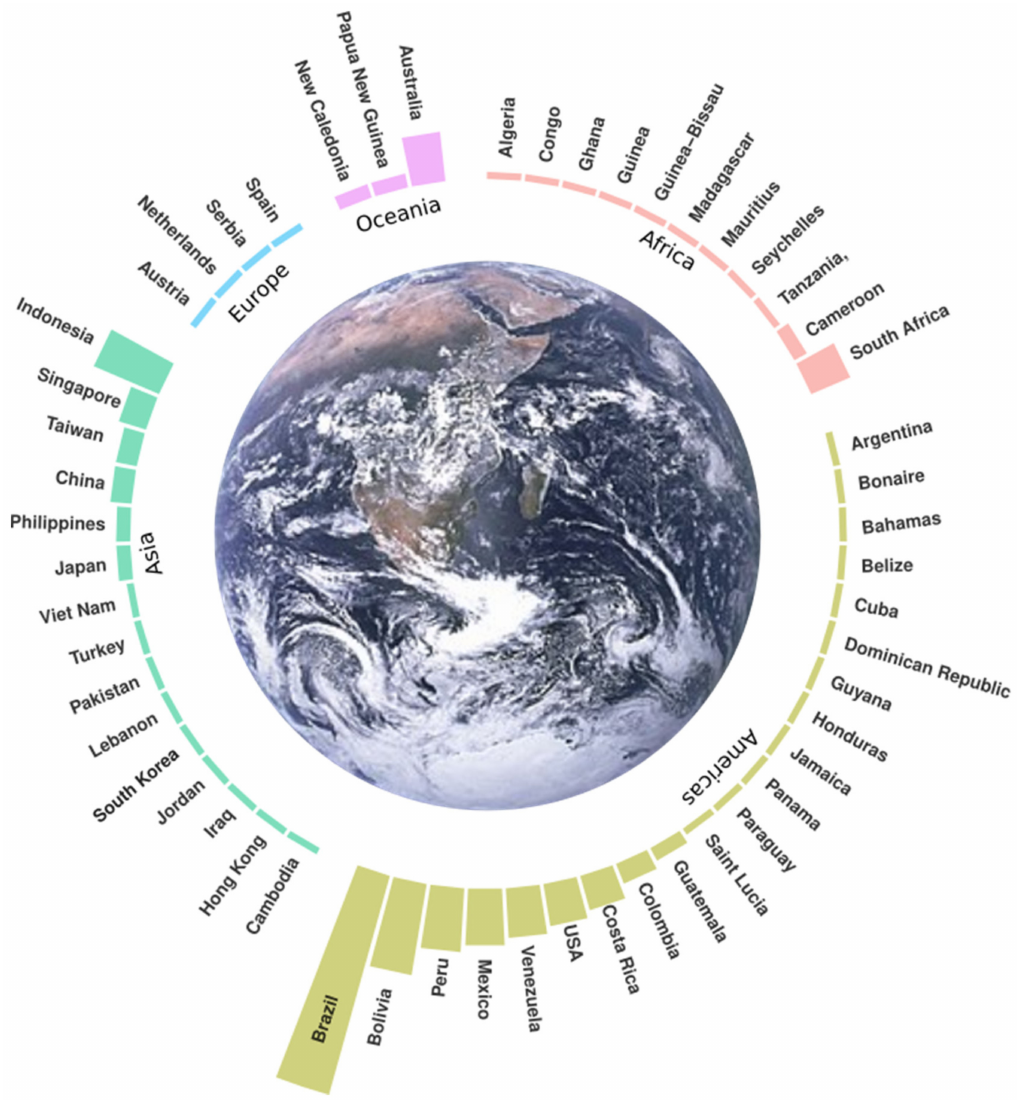
Figure 4. Geographical representation of published literature on the illegal parrot trade. Countries where studies were located are grouped by regions and ordered by number of documents